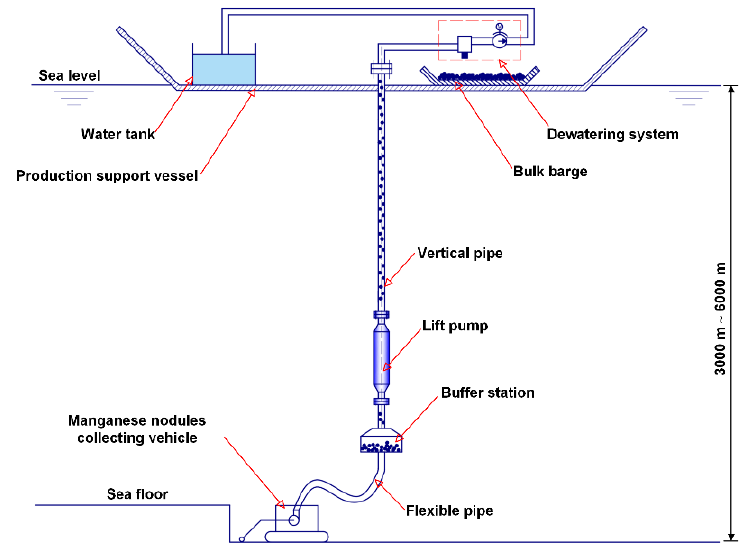
Figure 1. Schematic of the hydraulic mineral lifting system.